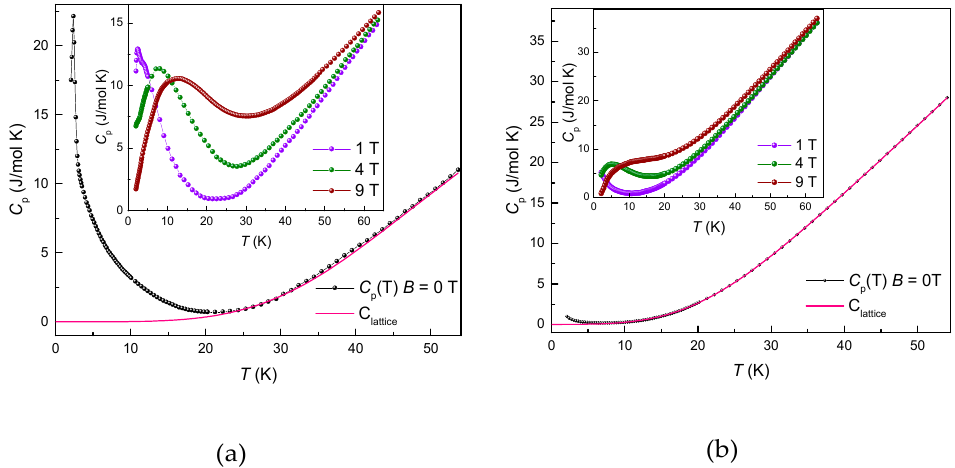
Figure 4. The temperature dependences of the specific heat C p in GdFeTeO 6 ( a ) and GdGaTeO 6 ( b ). The solid lines represent the Debye fitting of the phonon contributions. The insets show C p ( T ) curves taken in various magnetic